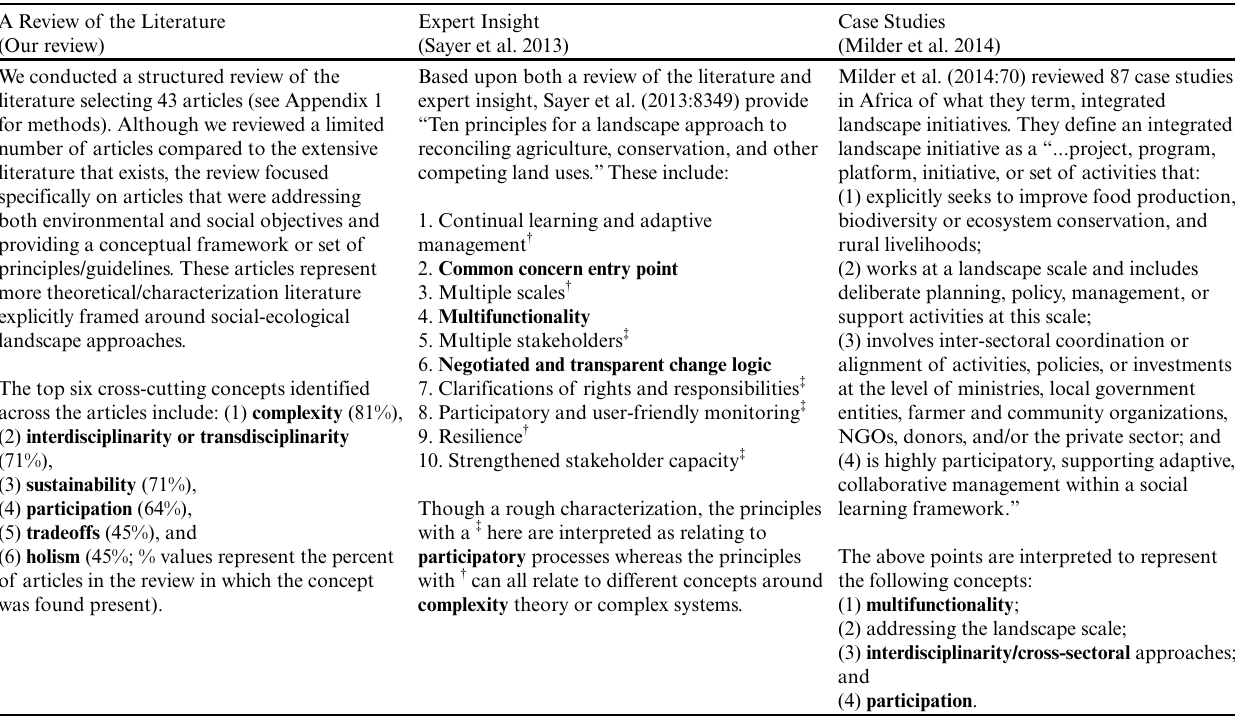
Table 3 . Summary of the main concepts for landscapes approaches (or initiatives) identified in our review of the literature, Sayer et al. (2013), and Milder et al. (2014). Bolded concepts are the main ones identified for comparison (Fig. 2). A Review of the Literature (Our review)